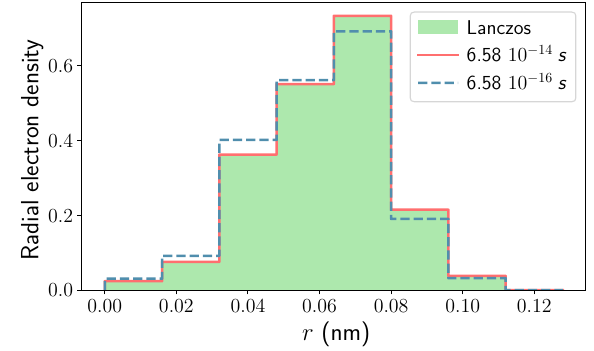
FIG. 13. The radial electron density obtained with AQC for T ∼ 1 /δ E (dotted blue) and T ∼ 100 /δ E (solid red), compared to the density obtained by diagonalization (green histogram) for the He atom, where δ E is the energy gap between the ground state and first excited states of the free-field